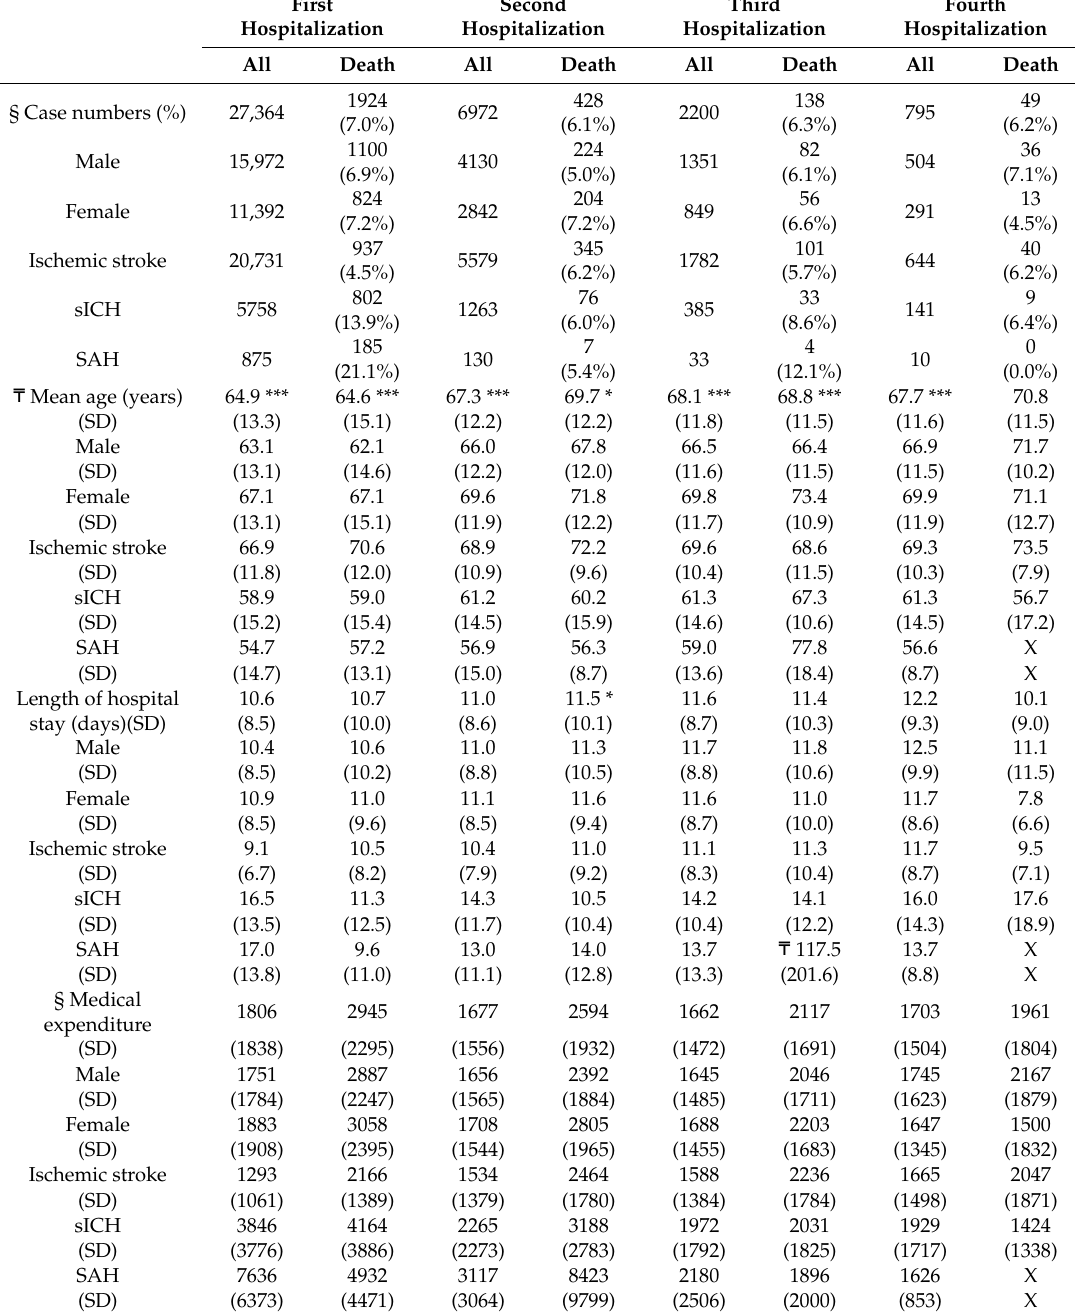
Table 2. Demographic data at different hospital admissions.